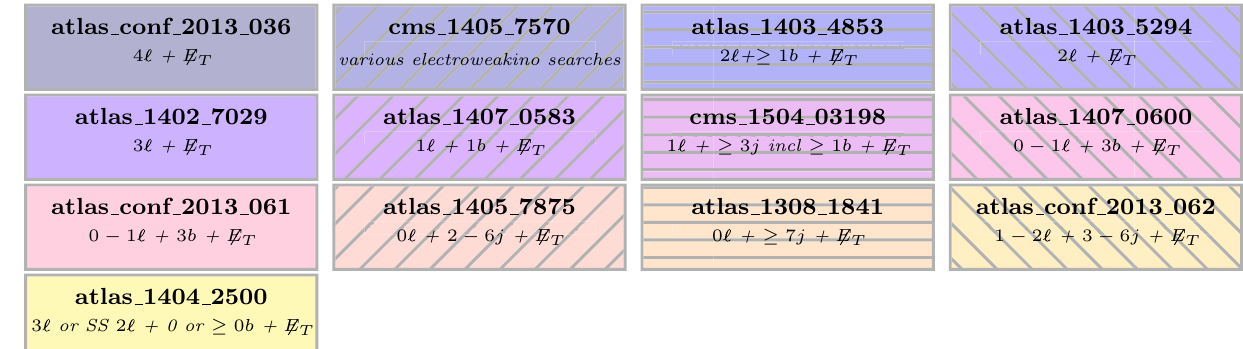
Fig. 10 This legend shows the different colors/shadings presented on the right-hand side of the following figures. Each colored box contains a bold label, which corresponds to the name under which the respective